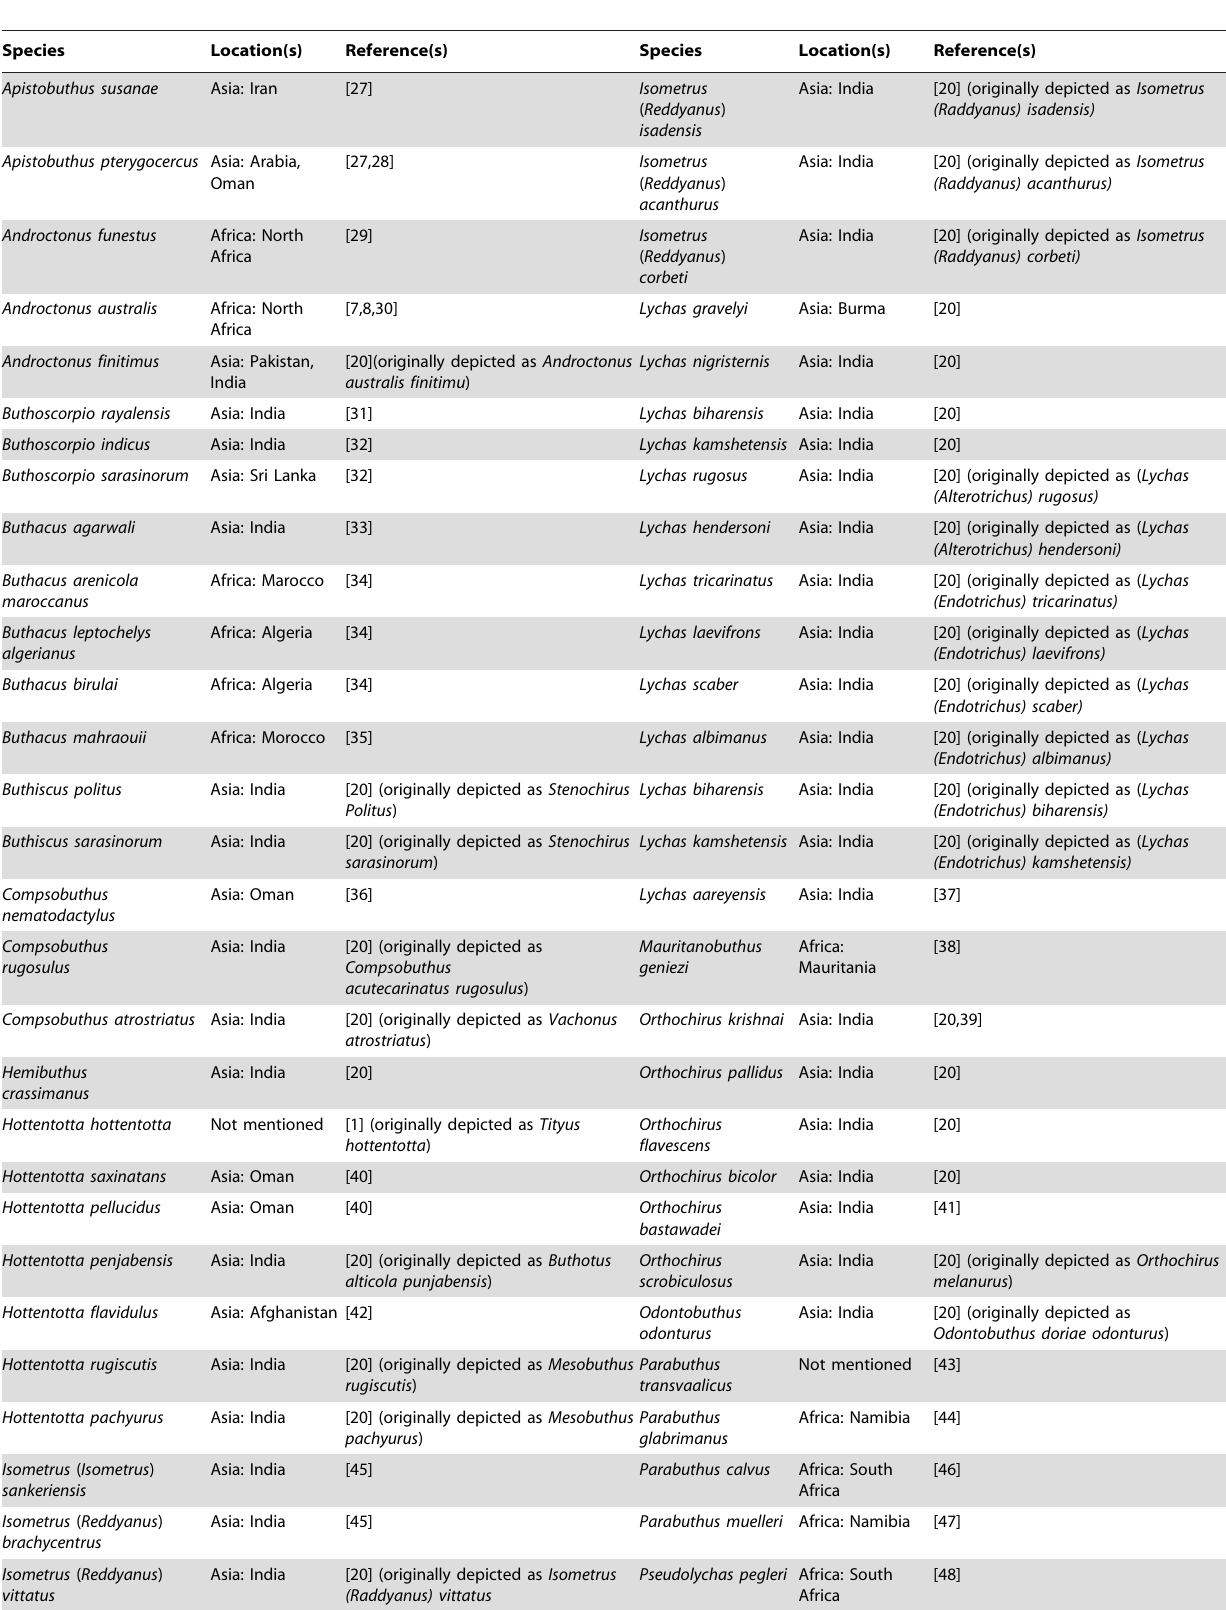
Table 2. Species and Publications with Descriptions of Five Pairs of Lateral Eyes.